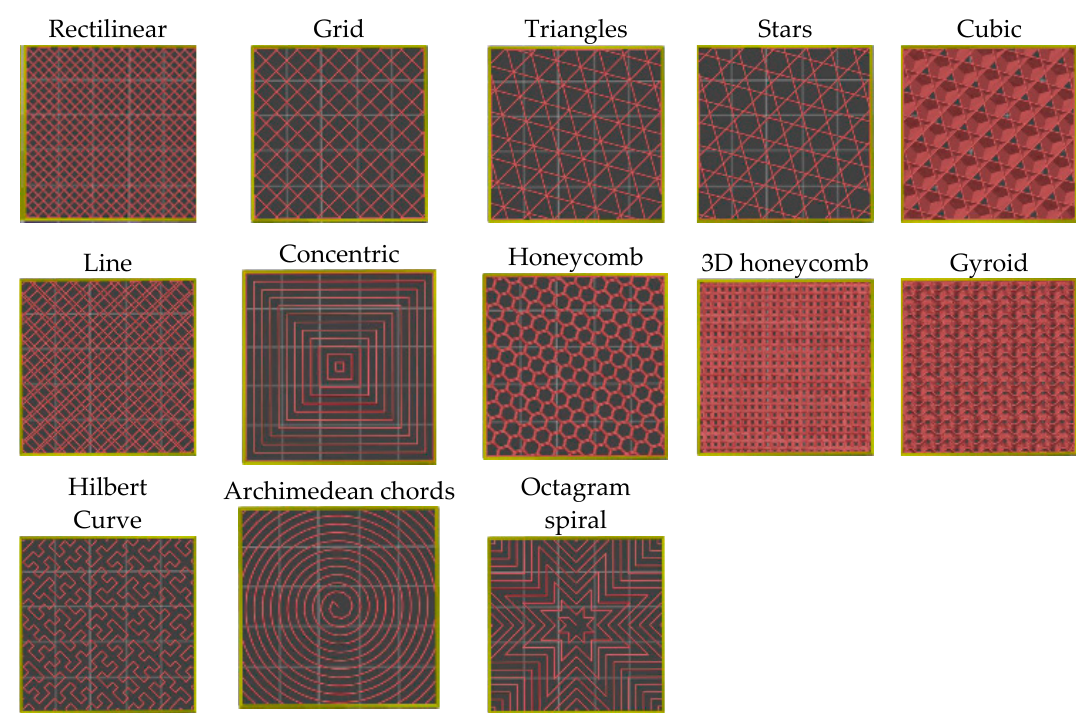
Figure 3. Types of infill pattern from the Slic3r PE software.